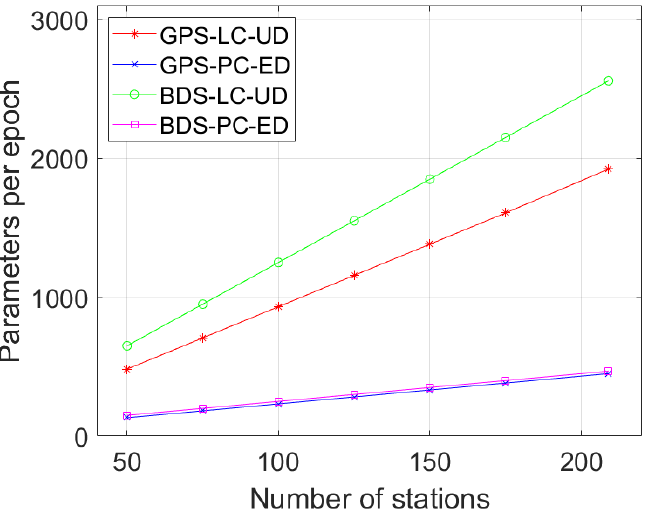
Figure 1. Efficiency of different models.